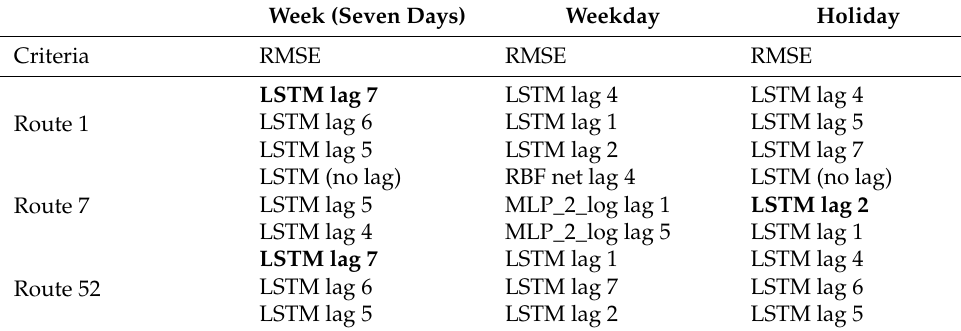
Table 10. Lag period of top three models for each route in different time